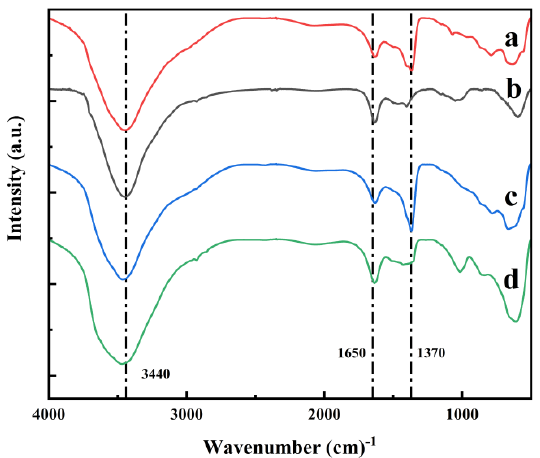
Figure 3. FTIR spectrums of ( a ) PTB-LDH3, ( b ) PTB-LDH4, ( c ) PTB-LDO3 and ( d ) PTB-LDO4.